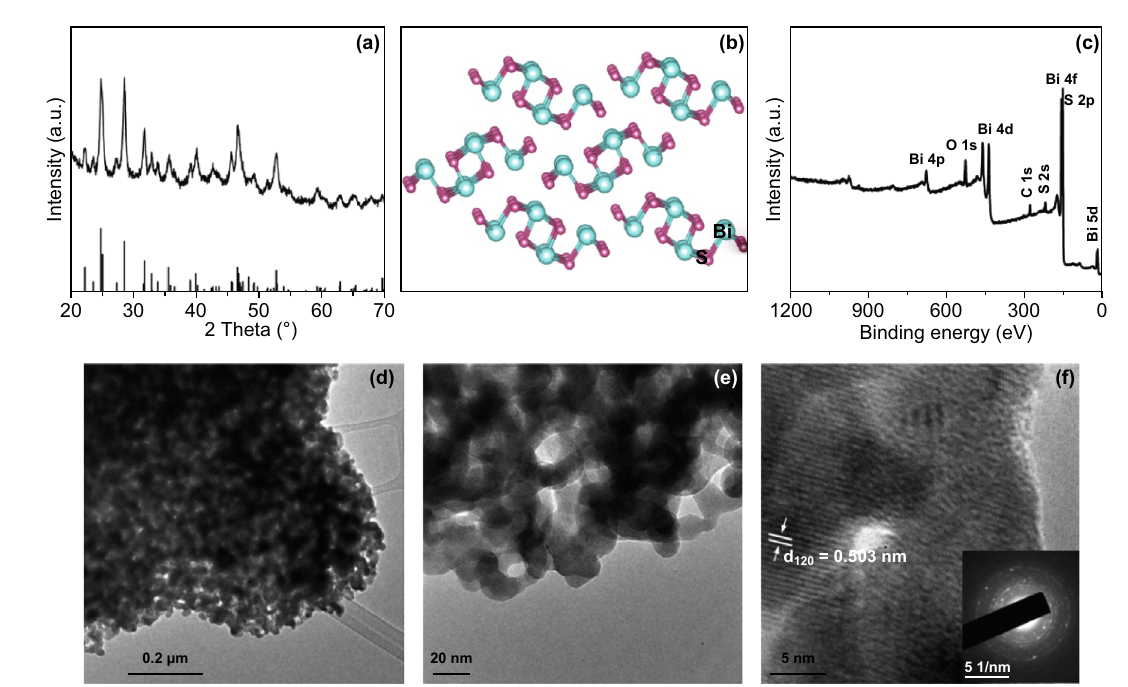
Fig. 1 a XRD pattern, b crystallographic structure, c XPS spectrum, d , e TEM images, and f High‑resolution TEM image of Bi 2 S 3 nanoparti‑ cles (inset of the SAED